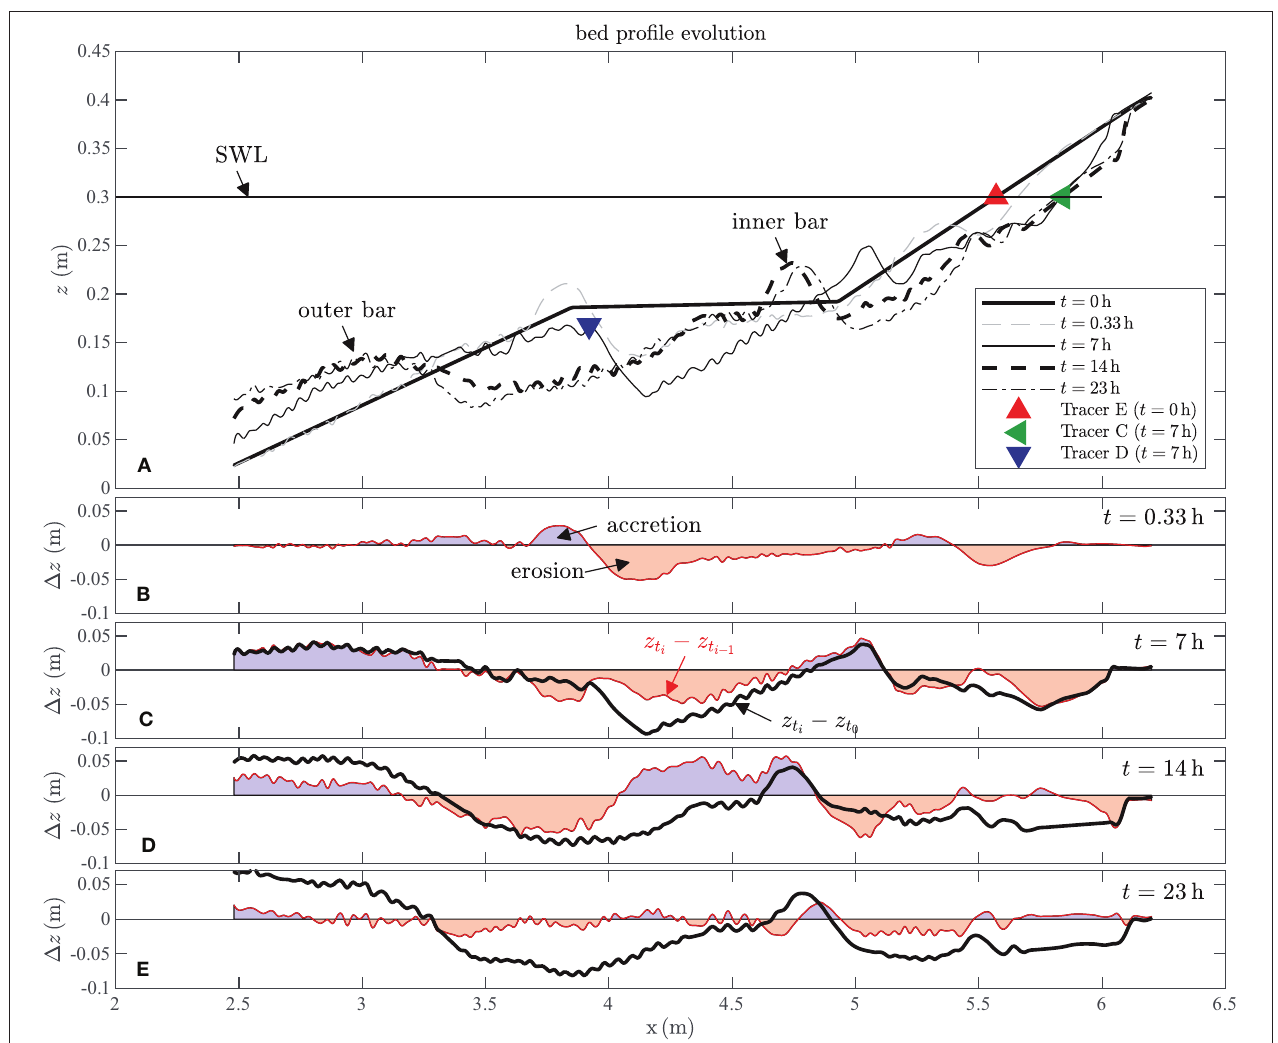
FIGURE 5 | Bed profile evolution. (A) Initial horizontal test section (bold black solid line), interim bed profiles after certain time (gray dashed line, black solid line), final bed profile (bold black dashed line), and bed profile after equilibrium survey (black dash-dotted line). Location and time of added MP. (B) Erosive sections (red areas) and accretive sections (blue areas) after 20min, (C) after 7h, accumulative bed profile evolution (bold black solid line), (D) 14h, and (E) 23h to validate the equilibrium stage.